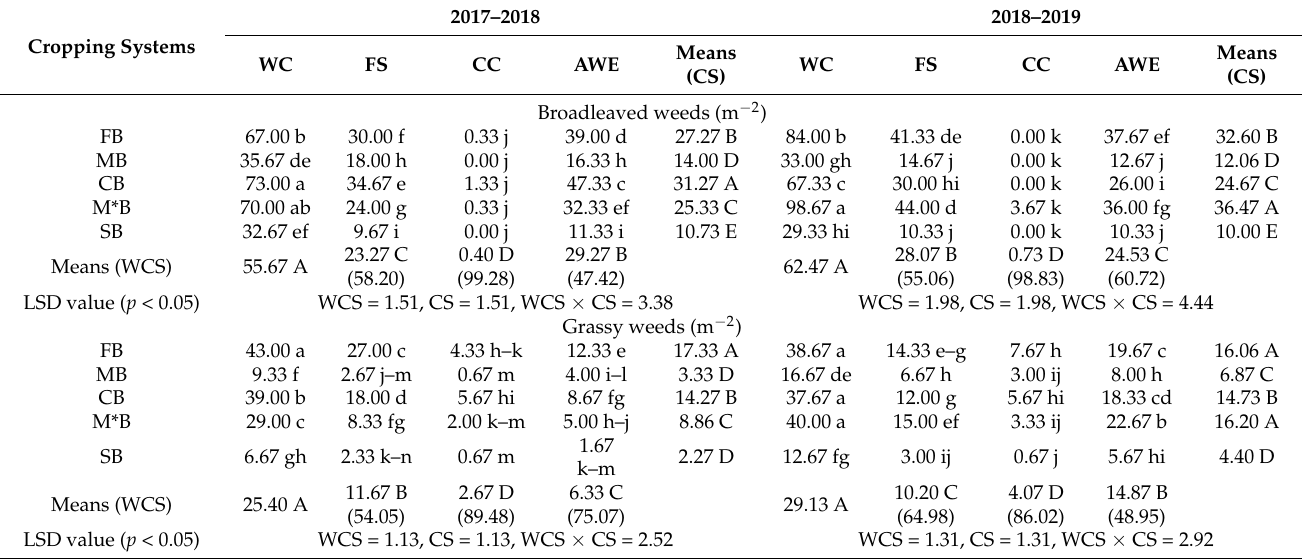
Table 2. Influence of different barley-based cropping systems on the overall density (m − 2 ) of broadleaved and grassy weed species under various weed management methods during 2017–2018 and